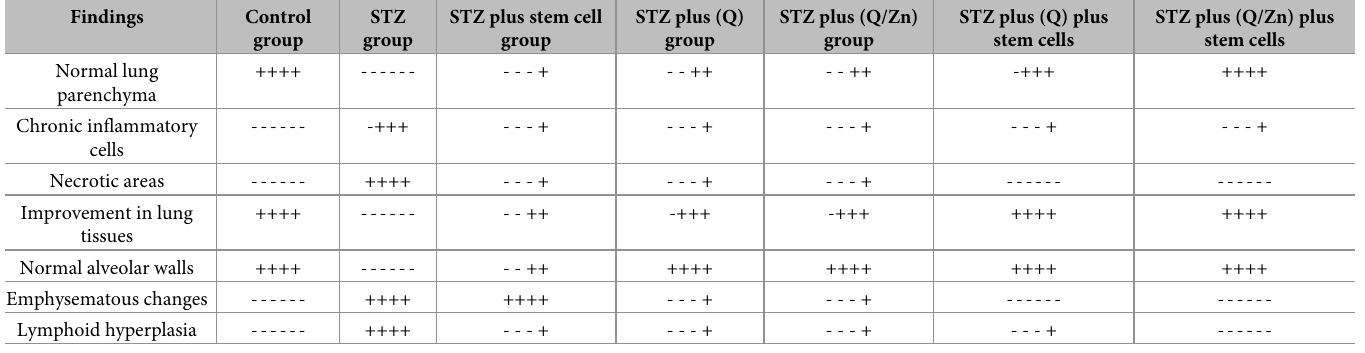
Table 8. Histopathological findings in pulmonary tissues of normal rats, diabetic non treated rats and diabetic treated rats with either quercetin, quercetin/Zn, or stem cells separately or in combination.